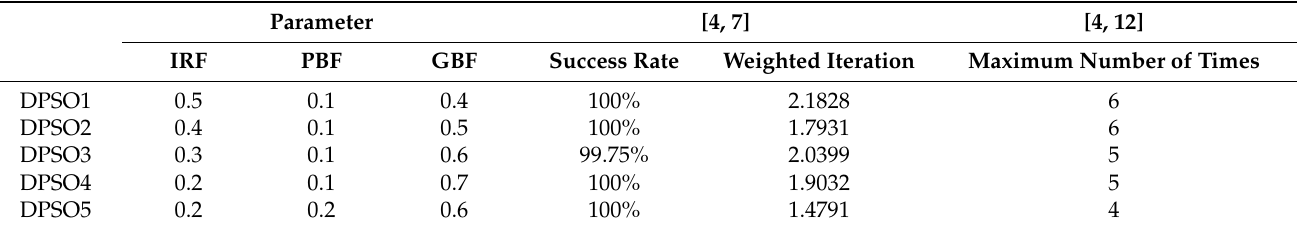
Table 5. Comprehensive comparison table of parameter tests of DPSO.